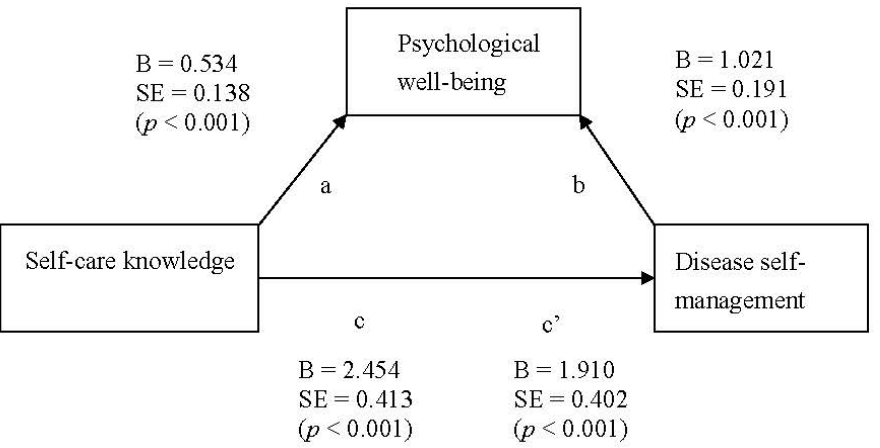
Figure 1. Mediating effect of psychological well-being.